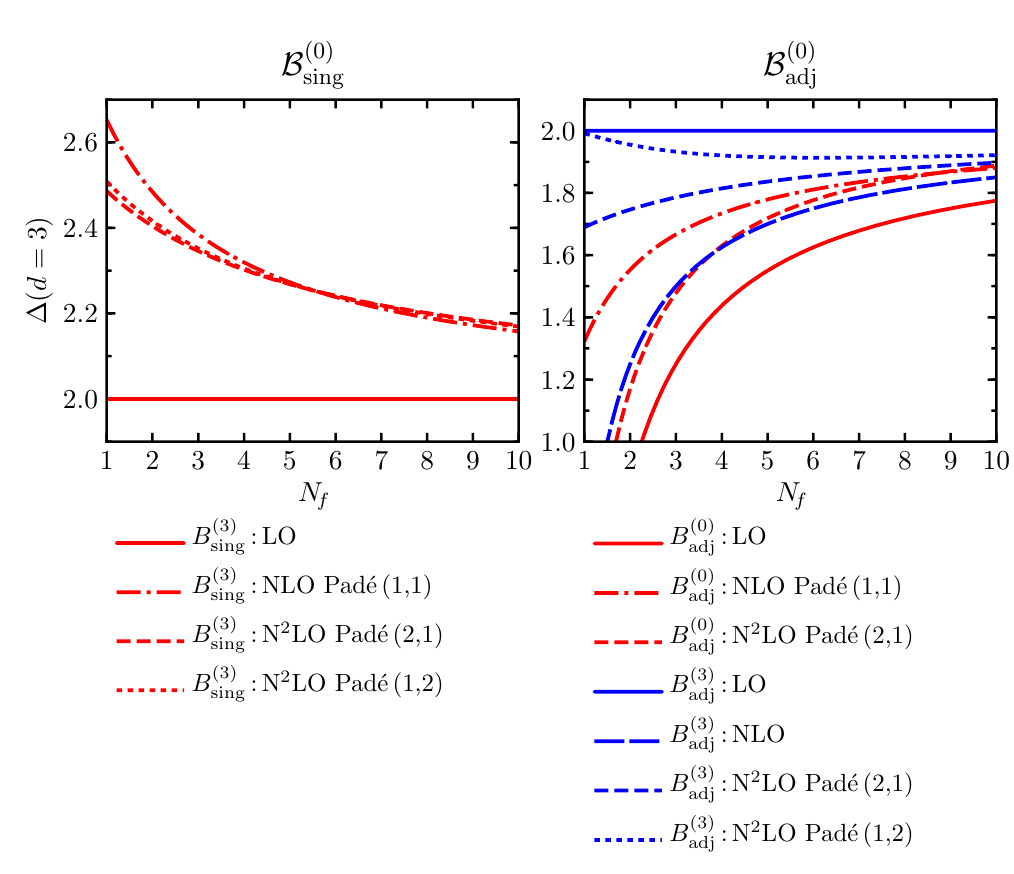
sing correspond to estimates adj